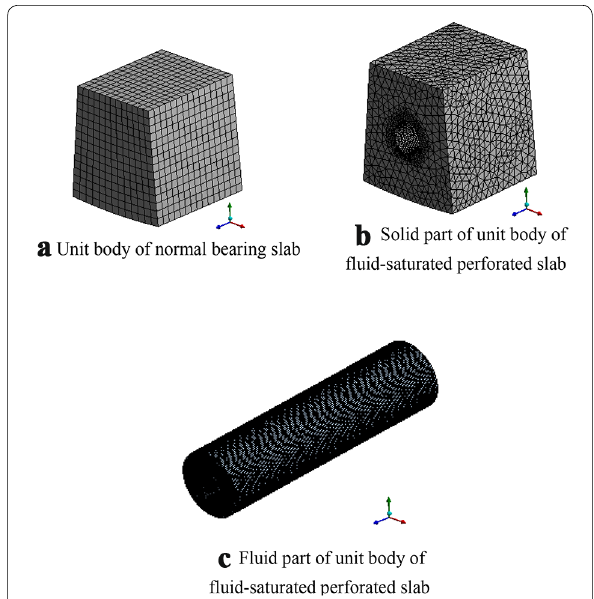
Figure 4 Meshing model diagrams. a unit body of normal bearing slab, b solid part of unit body of fliud-satruated perforated slab, c